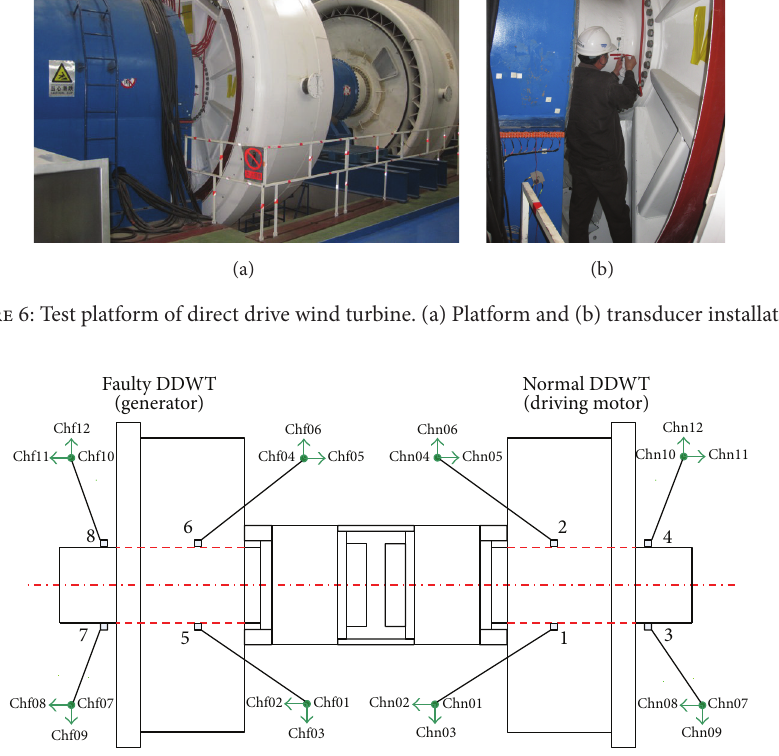
Figure 7: Placement of piezoelectric acceleration transducers.